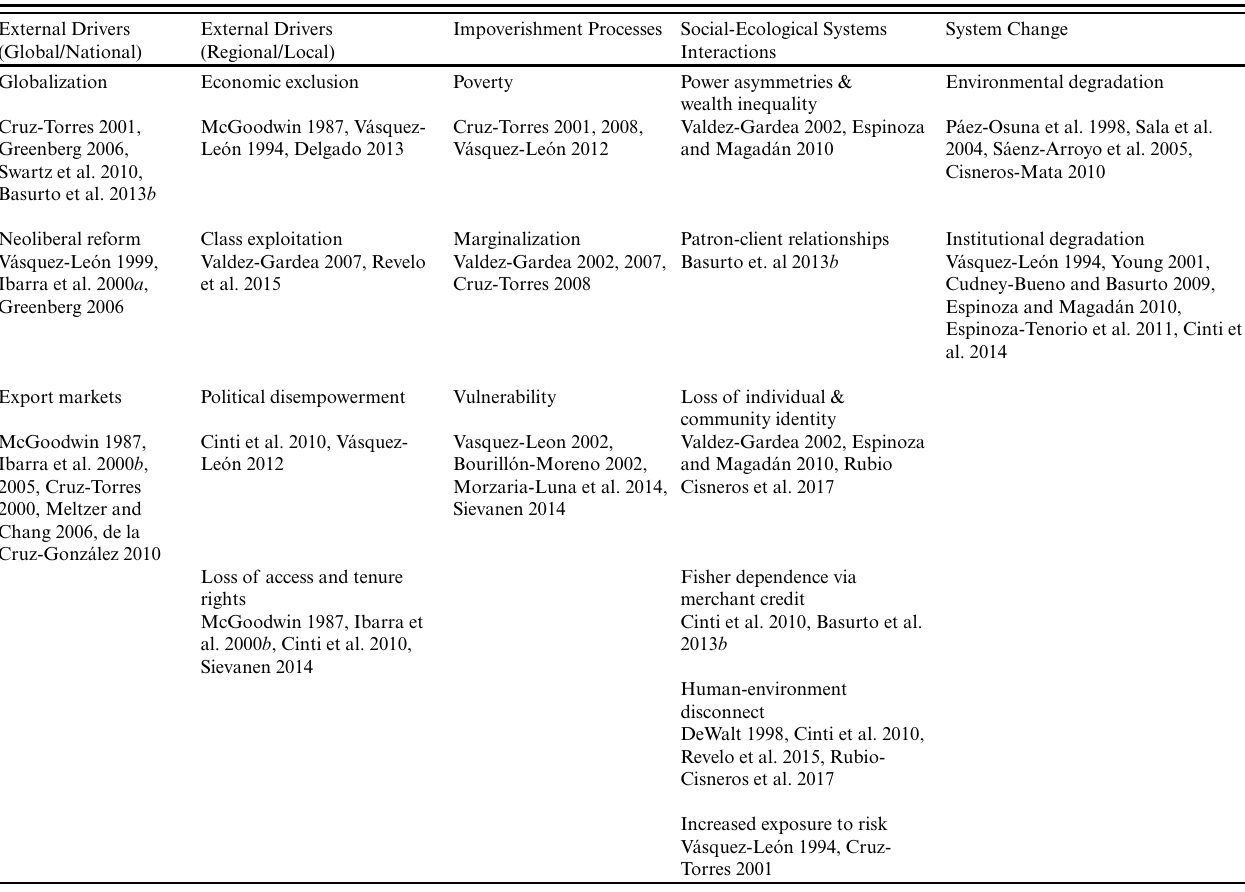
Table 1 . Summary of external drivers and processes influencing social-ecological outcomes within the Gulf of